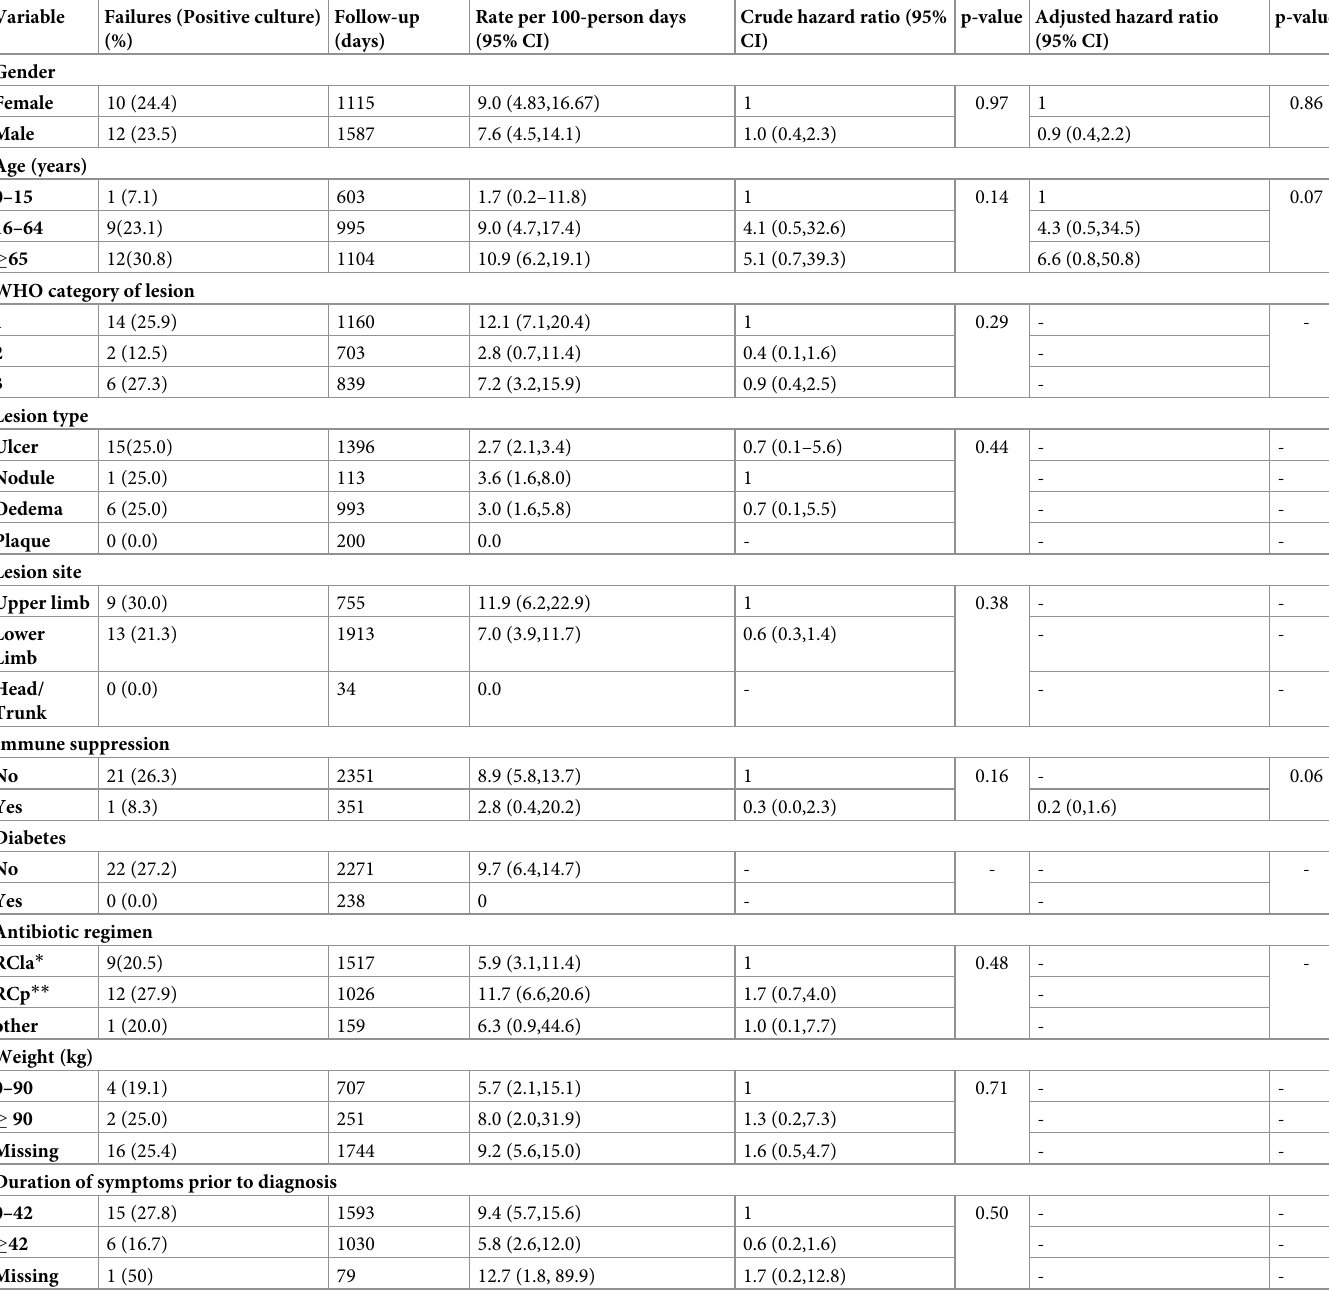
Table 2. Cox regression model showing adjusted and unadjusted associations between identified variable and rates of positive M . ulcerans culture.